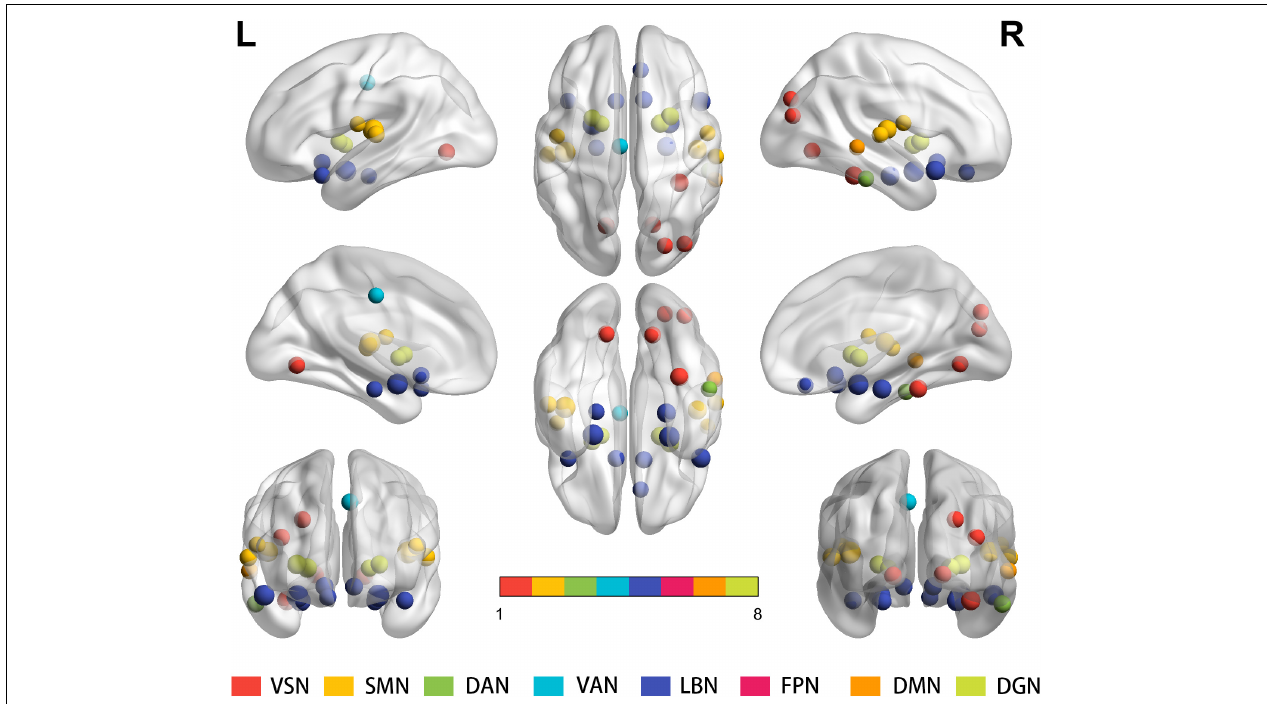
FIGURE 1 | Results for the total degree of connectivity between nodes at the integrity level. Statistical analysis indicates significant between-group differences regarding the total functional connectivity at the 27 nodes distributed within the VSN, SMN, LBN and DGN ( P < 0.05, FDR corrected). Same colored spheres represent ROIs from the same RSNs. ROIs, regions of interest; RSNs, resting-state network; VSN, the visual network; SMN, somatomotor network; DAN, dorsal attention network; VAN, ventral attention network; LBN, limbic network; FPN, frontoparietal network; DMN, default mode network; DGN, deep gray matter network; FDR, false discovery